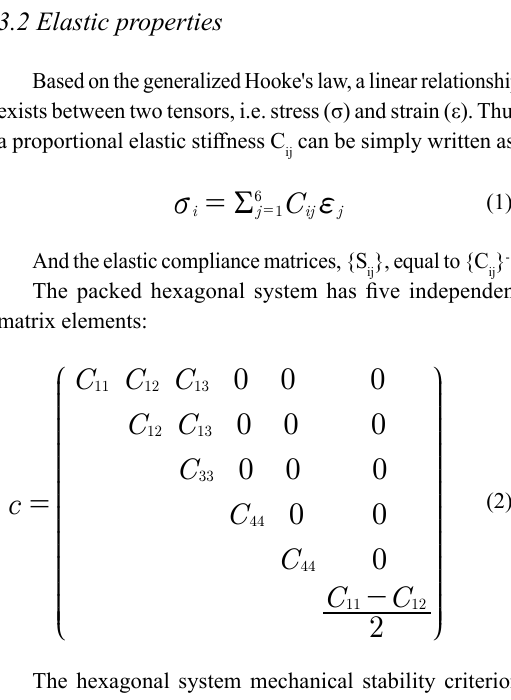
Table 3. Calculated elastic stiffness ( C